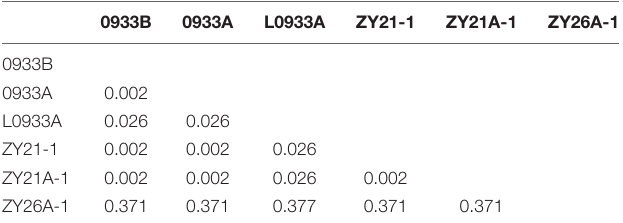
TABLE 2 | SNP locus estimates Nei genetic distance between parents and